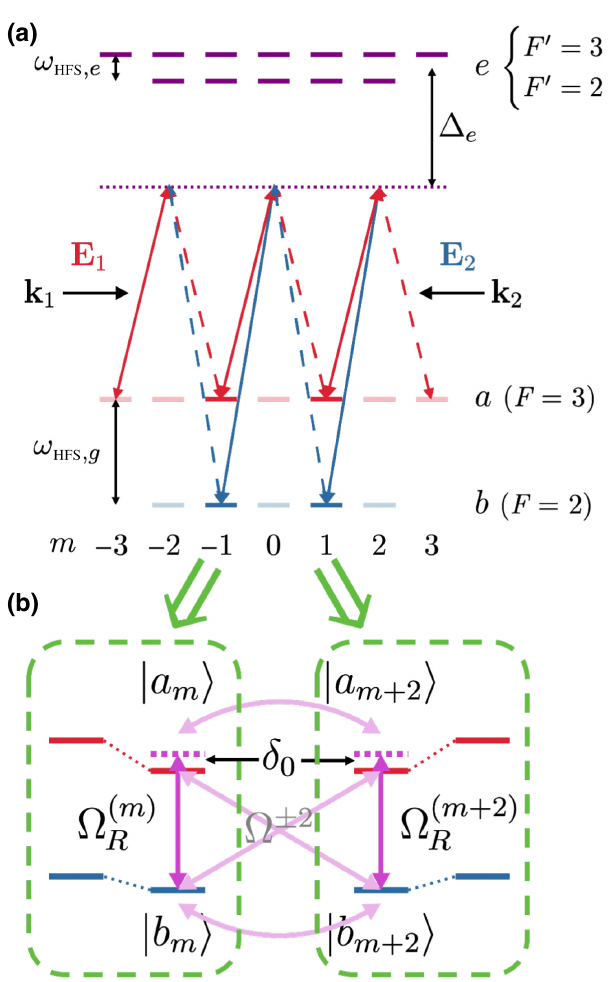
FIG. 1. Schematic of SDK on a hyperfine manifold, with the 85 Rb D1 line as the example in this work. (a) Cross-linearly polarized, counterpropagating E 1,2 resonantly drive the (cid:2) m = 0 and (cid:2) m = ± 2 Raman transitions. The optical couplings are illus- trated with solid and dashed lines, with m = ± 1, ± 3 ground states as examples. When the single-photon detuning (cid:2) e is much larger than the excited state hyperfine splitting ω HFS, e , the (cid:2) m = ± 2 couplings through the F (cid:3) = 2, 3 intermediate states largely cancel each other, leading to decoupled {| a m (cid:4) , | b m (cid:4)} sub- spin systems. (b) The reduced level diagrams for the weakly coupled {| a m (cid:4) , | b m (cid:4)} systems ( m = ± 1). The bare levels are rel- atively shifted and Raman coupled. The effective Hamiltonian , δ 0 for Eqs. (1) (2) (3) are marked. The dif- parameters (cid:5) ± 2 , (cid:5) ( m ) R ferential Stark shift δ 0 is largely responsible for the SDK dynamic phase [Eq. (5)]. Similarly coupled subspin systems composed of (cid:4) , | b (cid:4)} with m = 0, ± 2 are not {| a m m